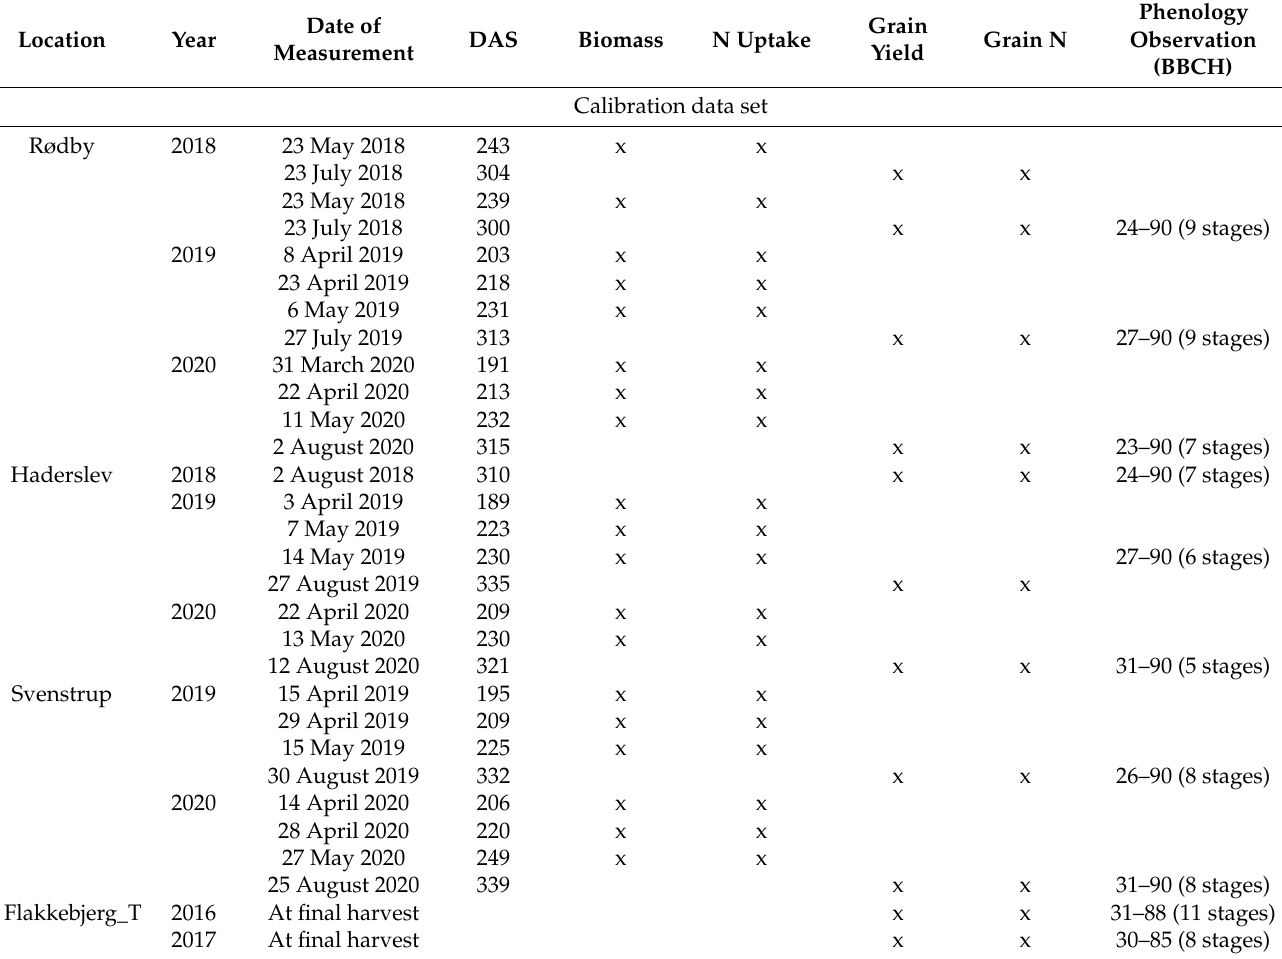
Table 3. Measurement dates of the variables used for calibration and evaluation. DAS = days after sowing. The number of BBCH assessments that were performed during the crop cycle are mentioned in the parenthesis in phenology observation